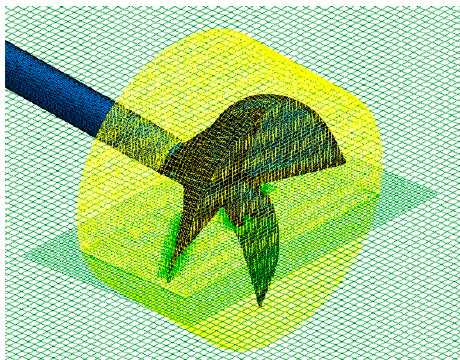
Figure 5. Local mesh of SPP-1 and interface.